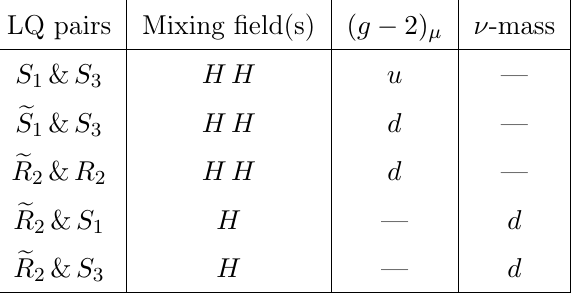
Table 2 . Scalar LQ pairs that can, through the mixing with the SM Higgs field, generate either the one-loop contributions towards ( g 2) (cid:22) or neutrino mass. It is indicated whether the chirality- (cid:0) enhanced contributions are proportional to the up-type ( u ) or down-type ( d ) quark